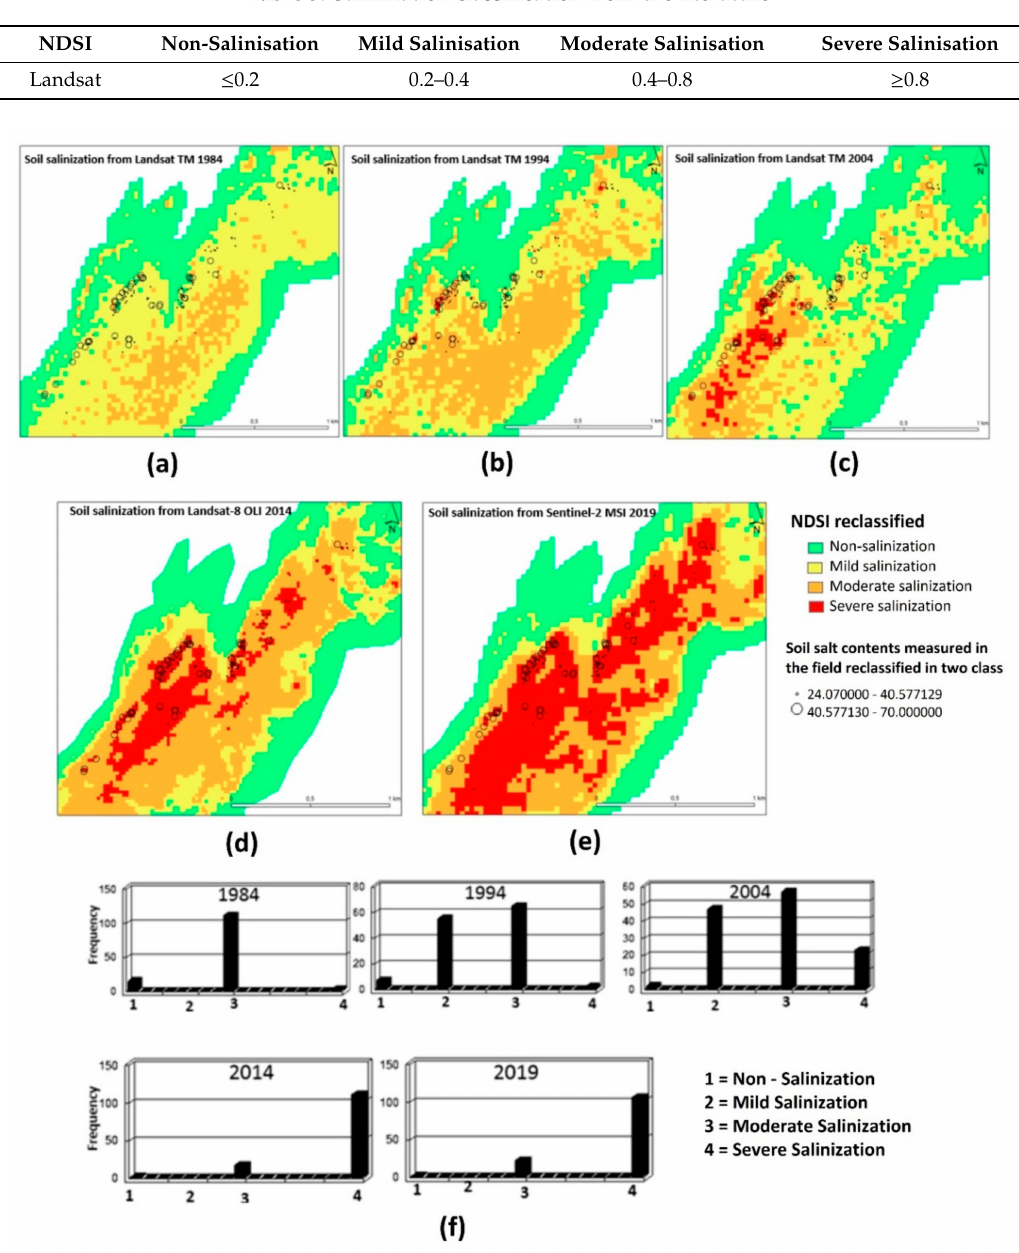
Table 3. Salinization classification from the literature.